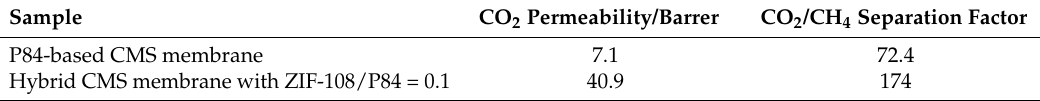
Table 12. Mixed gas permeability and separation factor for P84-based CMS membrane and